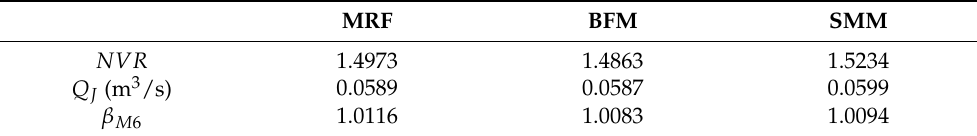
Figure 20. Non-dimensional axial velocity distribution at station 3 and 6 with three different models. Table 8. Results of NVR , Q J and β M 6 at station 6 with the MRF model, body-force model (BFM) and sliding mesh model (SMM).